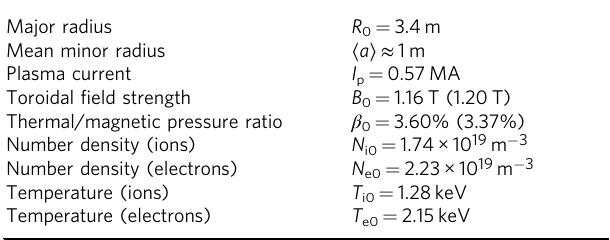
Table 1 Plasma parameters in simulations based on JT-60U shot number